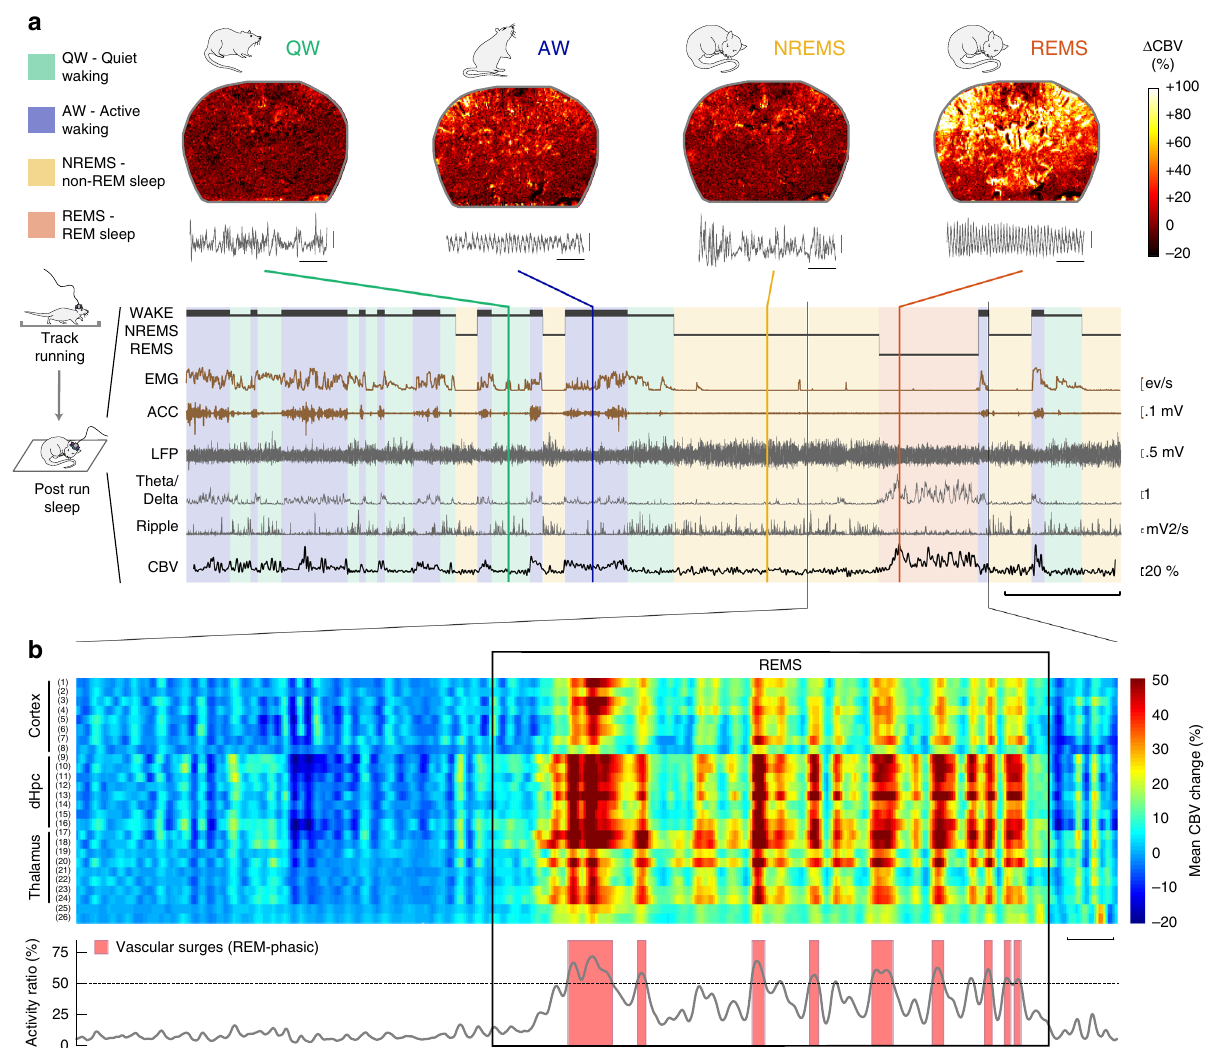
Fig. 1 REM sleep is characterized by massive brain-wide hyperemia. a Typical fUS-EEG recording during sleep subsequent to a track-running task. Sleep scoring is performed by using neck electromyogram (EMG), head acceleration (ACC), and hippocampal local fi eld potential (LFP) to discriminate between quiet wake (QW), active wake (AW), non-REM sleep (NREMS), and REM sleep (REMS). REMS periods are characterized by high theta/delta ratio, low ripple content and elevated cerebral blood volume (CBV). Scale bar: 5 min (Top) Four typical Power Doppler images (CBV, voxel resolution: 100 × 100 × 400 μ m) for each state and corresponding 5-s LFP trace. Scale bar: 1 s. Note the similarity in the EEG patterns (theta activity) between AW and REMS, contrasted by the discrepancy in the vascular patterns. b Regional hemodynamics during a transition between NREMS to REMS. (Top) High-amplitude vascular patterns are present in almost all brain regions and more sustained in the dorsal thalamus and hippocampus. (1 – 2) Auditory cortex, left and right, respectively; (3 – 4) Primary somatosensory barrel fi eld cortex; (5 – 6) Lateral parietal association cortex; (7 – 8) Retrosplenial cortex; (9 – 10) CA1 region; (11 – 12) CA2 region; (13 – 14) CA3 region; (15 – 16) Dentate gyrus; (17 – 18) Dorsal thalamus; (19 – 20) Post-thalamic nuclear group; (21 – 22) Ventral posteromedial thalamic nucleus; (23 – 24) Whole thalamus; (25 – 26) Hypothalamic region. Scale bar: 20 s. (Bottom) Phasic vascular events (vascular surges) are detected when the proportion of active voxels (gray curve) crosses 50% of total voxel amount. A pixel is «active» when its value is higher than one standard-deviation above active wake